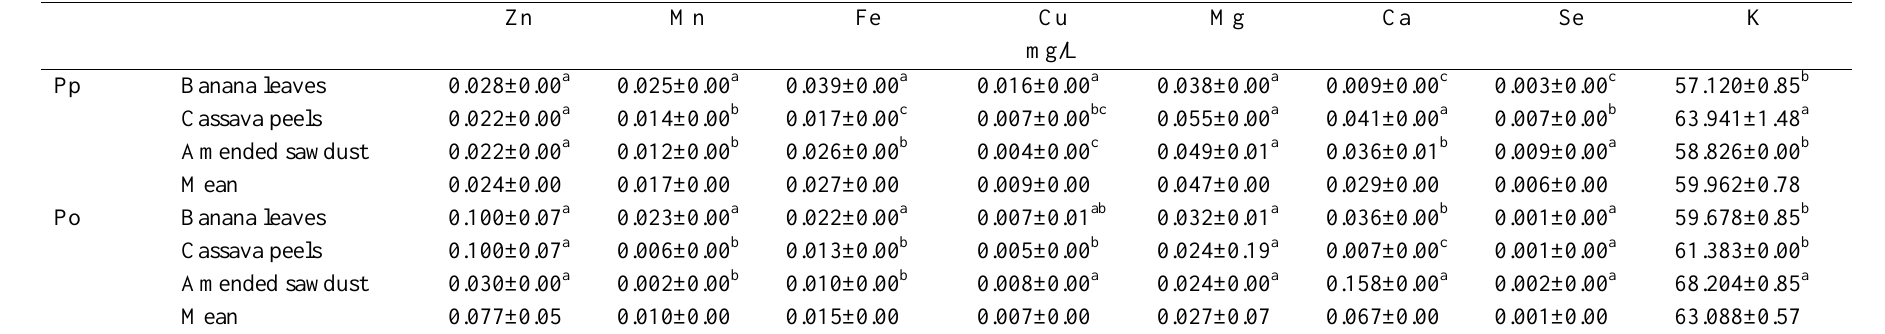
Table 3: Mineral analysis of Pleurotus pulmonarius and Pleurotus ostreatus as influenced by